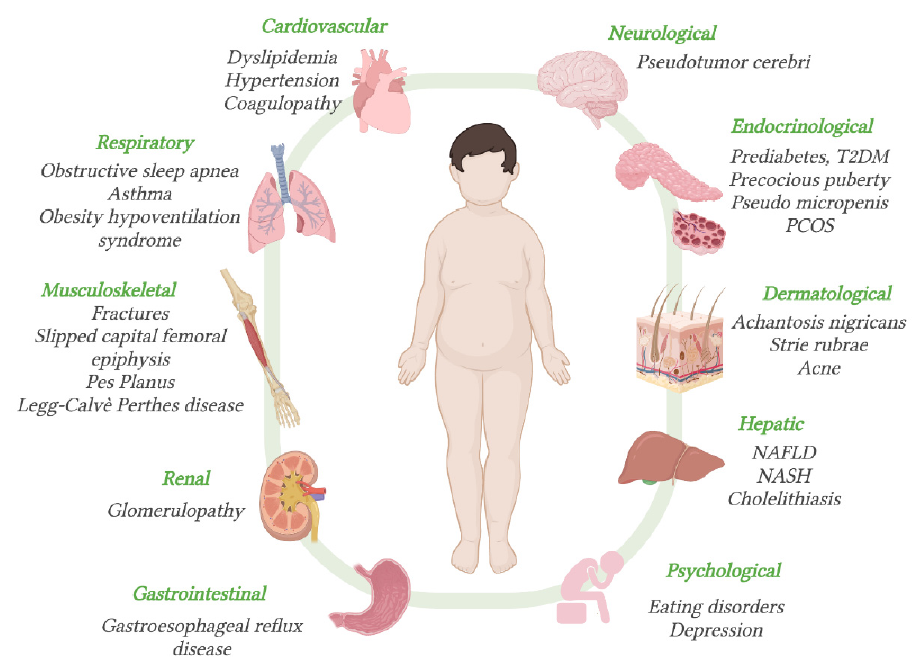
Figure 1. Obesity-related complications. T2DM = type 2 diabetes mellitus; PCOS = polycystic ovarian syndrome; NAFLD = nonalcoholic fatty liver disease; NASH = nonalcoholic steatohepatitis.